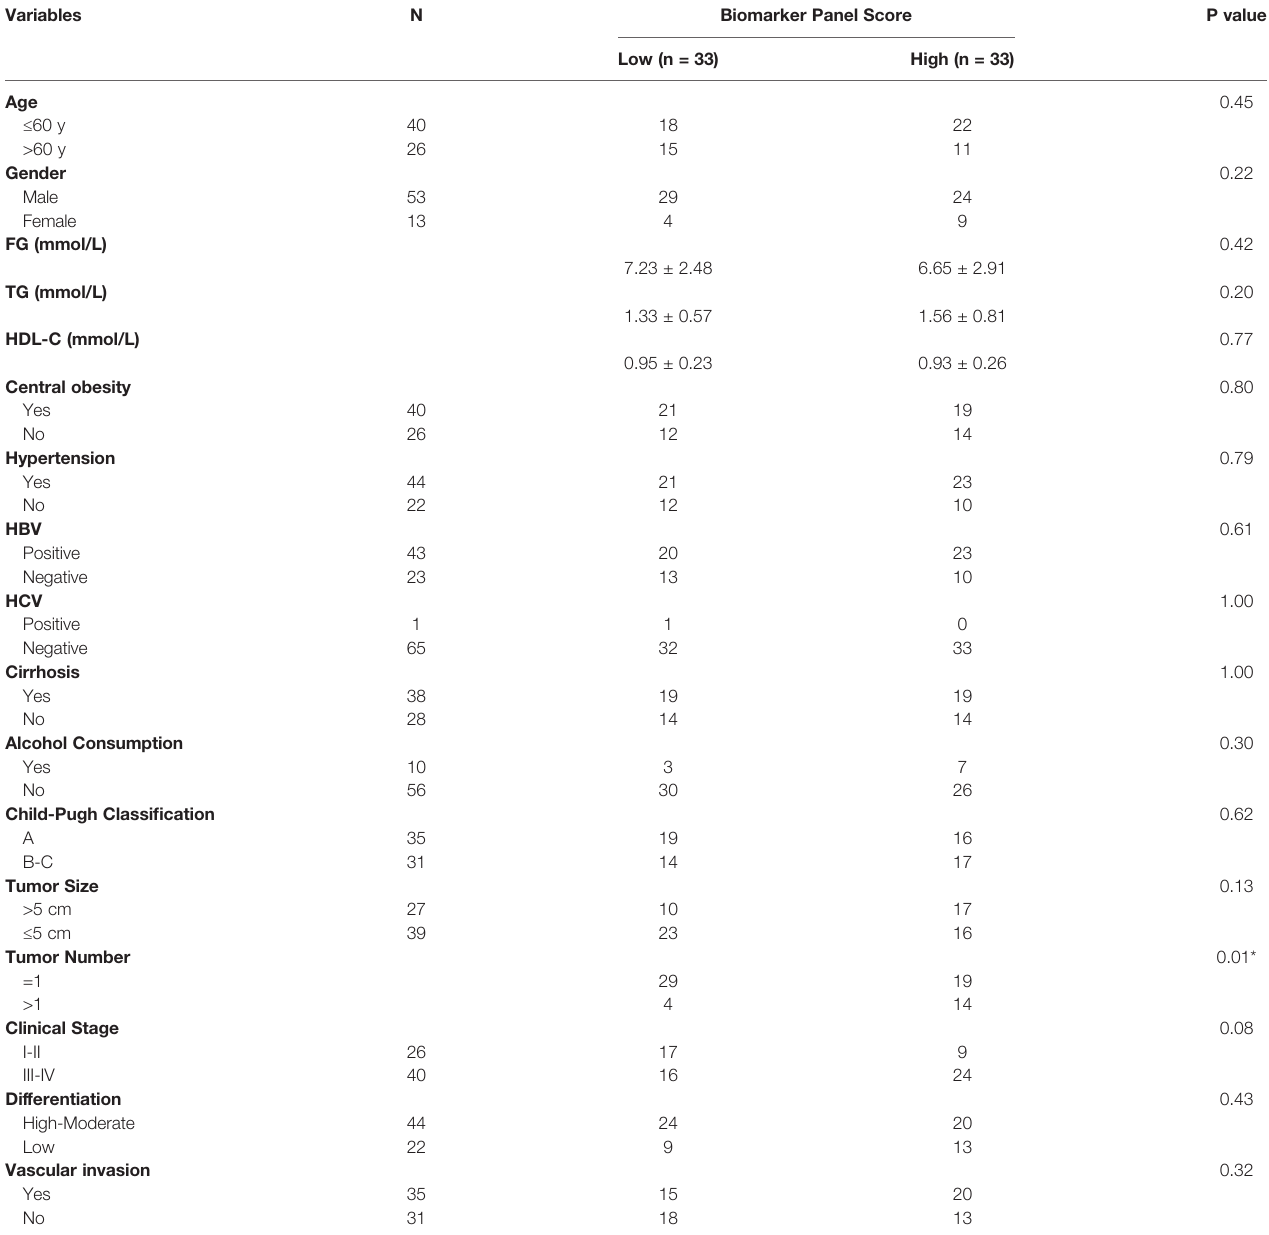
TABLE 3 | Correlation of the score of the biomarker panel with clinical variables in MetS(+) HCC patients in the validation